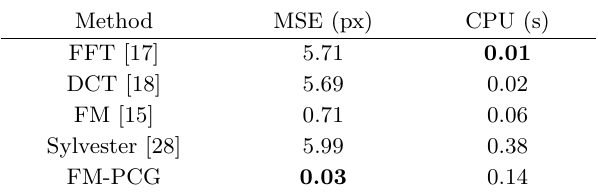
Table 15 Results on the “Vase” dataset for the non-rectangular domain in Fig. 12(b)